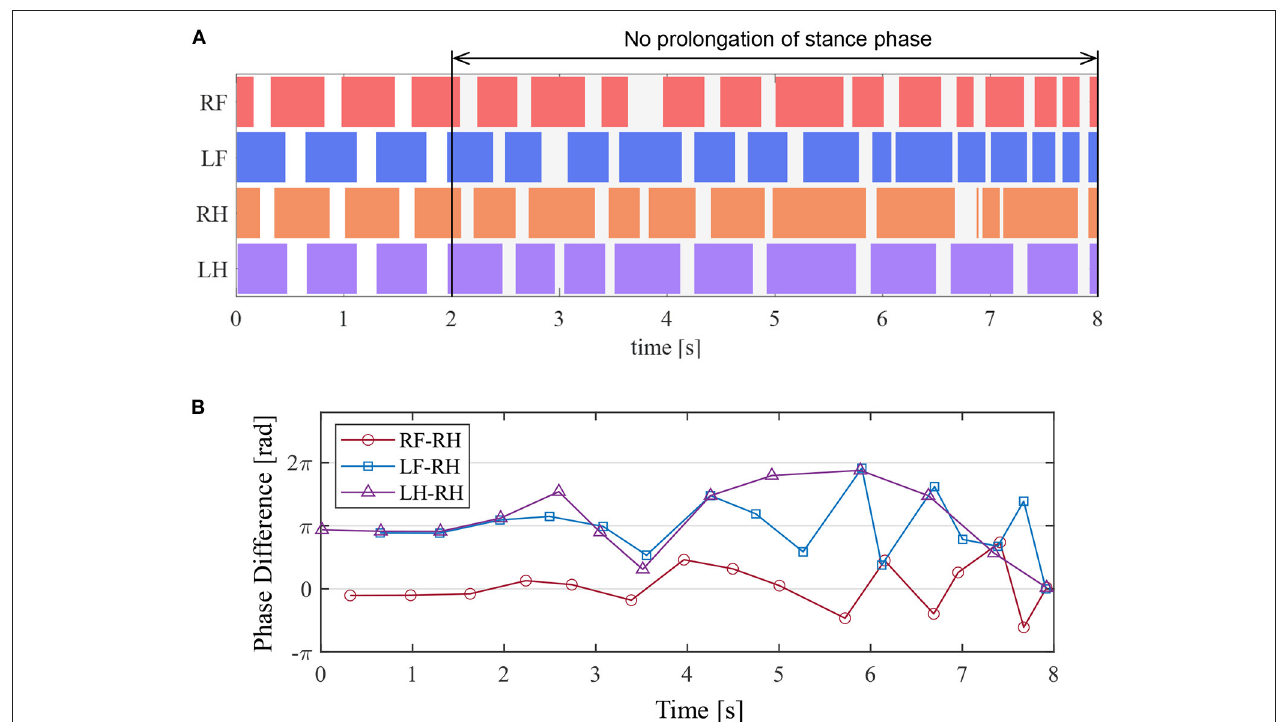
FIGURE 13 | Experimental result to disable the prolongation function of the stance phase. (A) Gait chart. The colored regions indicate ground contact. (B) The phase difference between each leg and the right hind